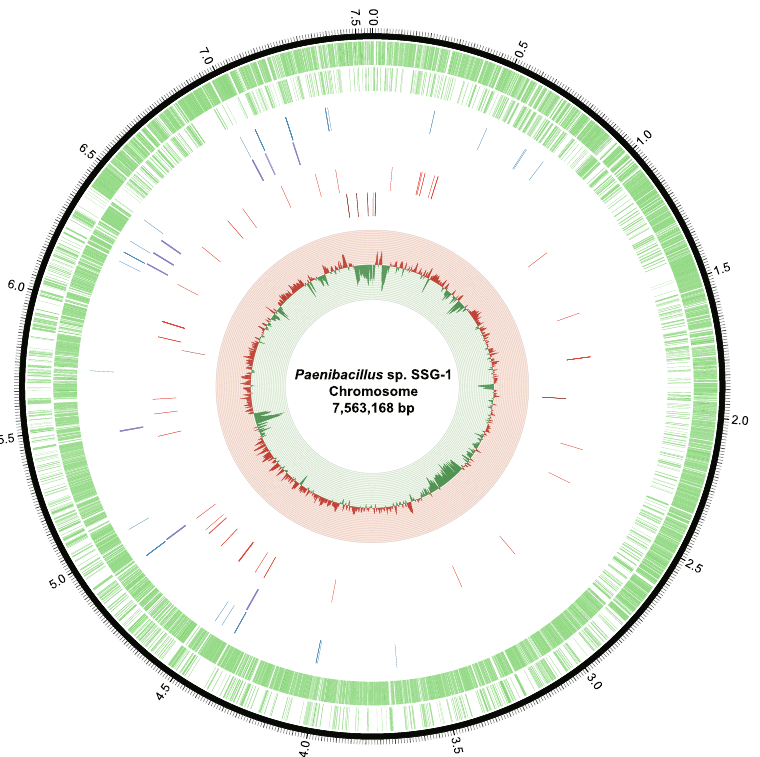
Figure 1. Circular diagrams of the Paenibacillus sp. SSG-1 chromosome. Information from the outermost circle to the innermost circle provide the following data: (1) position in megabases (black); (2) forward strand CDSs (green); (3) reverse strand CDSs (green); (4) tRNAs (blue); (5) rRNAs (purple); (6) repeats (red); (7) ISs and TEs (dark red); and (8) deviation of the GC content per 5000 bp compared with the global genome (positive: red; negative: green; wave range: −